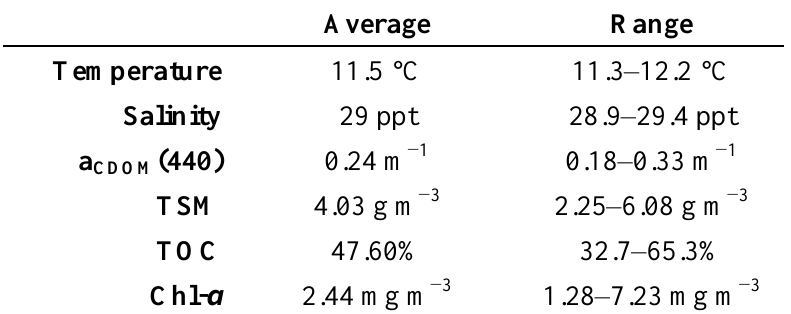
Table 1. Water optical constituents profile for Sidney Spit field sites.